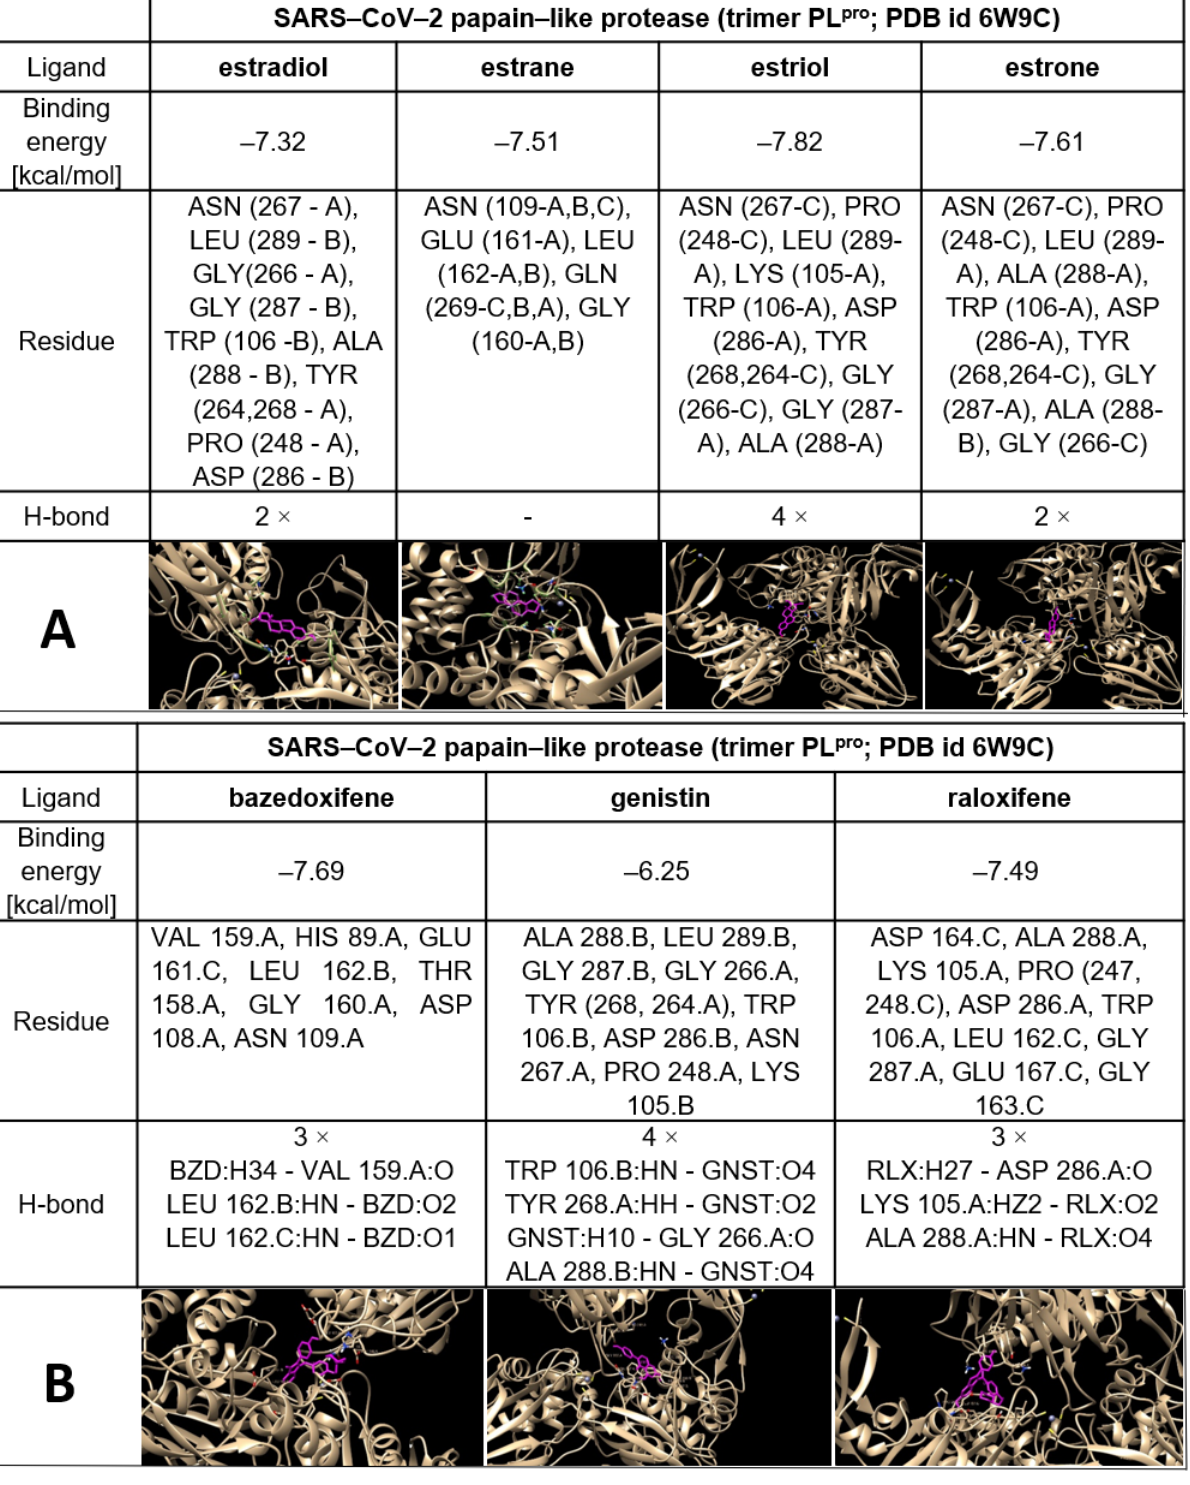
Figure 6. The best docking pose of oestrogens ( A ) and other examples of ERM such as bazedoxifene, genistin and raloxi- fene ( B ) to the SARS − CoV − 2 papain-like protease structure (PL pro ) (trimer form) with characterization of the interaction including hydrogen bonds.